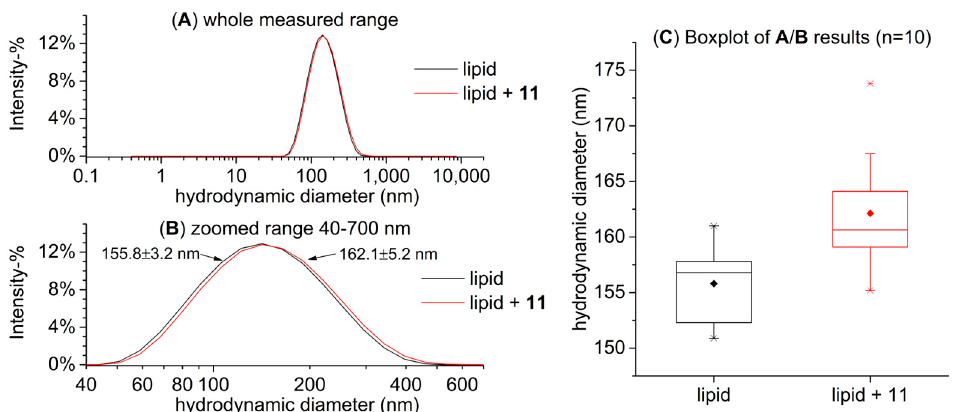
Figure 7. Hydrodynamic particle size distribution based on intensity of a 2 mM lipid solution soni ‐ cated for 360 min after freeze–thaw treatment alone and with the addition of pentagalloylglucose ( 11 ): ( A ) the whole measured range, ( B ) a zoomed range of 40–700 nm to highlight the difference between samples (mean ± SD, n = 10), and ( C ) boxplots of the main peak size for both samples ( n = 10).